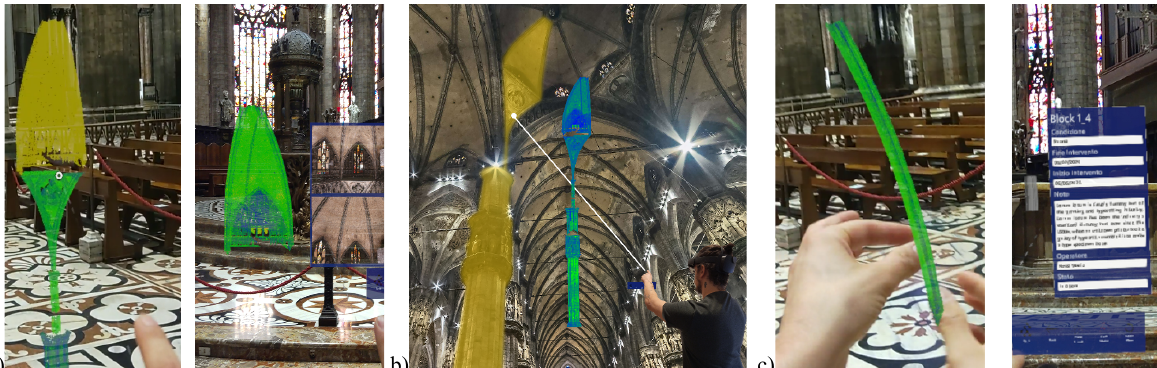
Figure 5. MR access to the segmented 3D point cloud of the Milan Cathedral. Pillar element visualised in front of the main altar (a), pillar, pendentive and vault section (b) and single marble element (with associated attributes about maintenance) isolated and displayed at higher